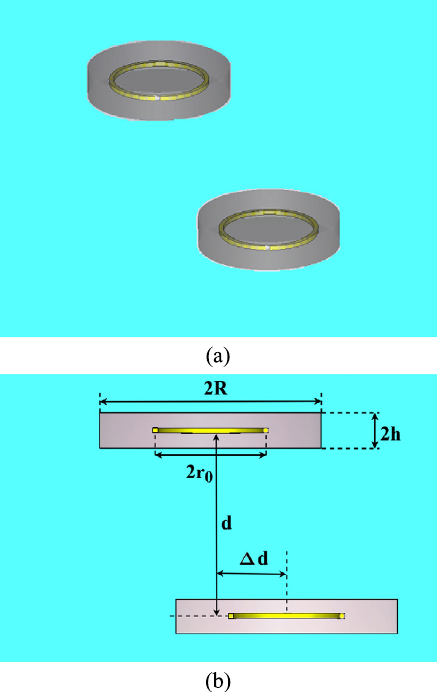
Fig. 1. (a) Persepctive and (b) cross section of the investigated con fi guration consisting of two coils with the same orientation, completely immersed in a conductive medium. Each coil is insulated by a dielectric box to prevent current